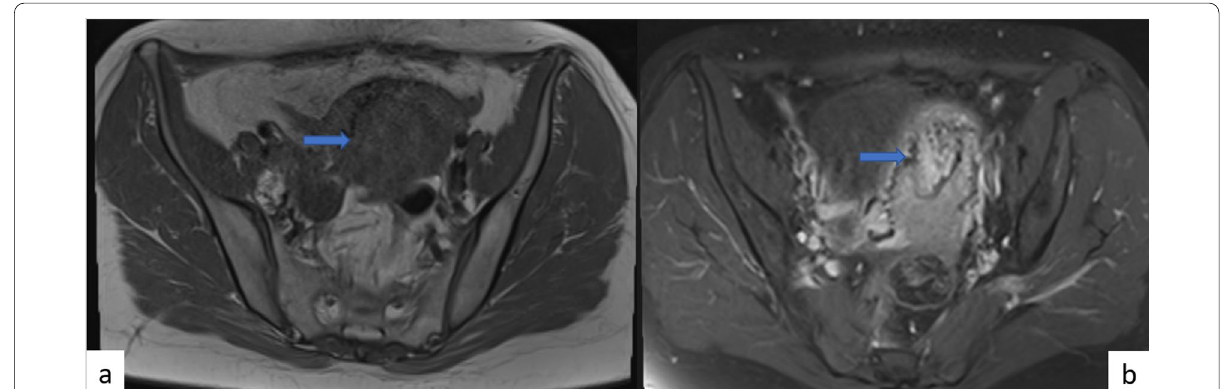
Fig. 3 Pre and post-contrast axial T1 WI showing the heterogeneous intense enhancement of the mass